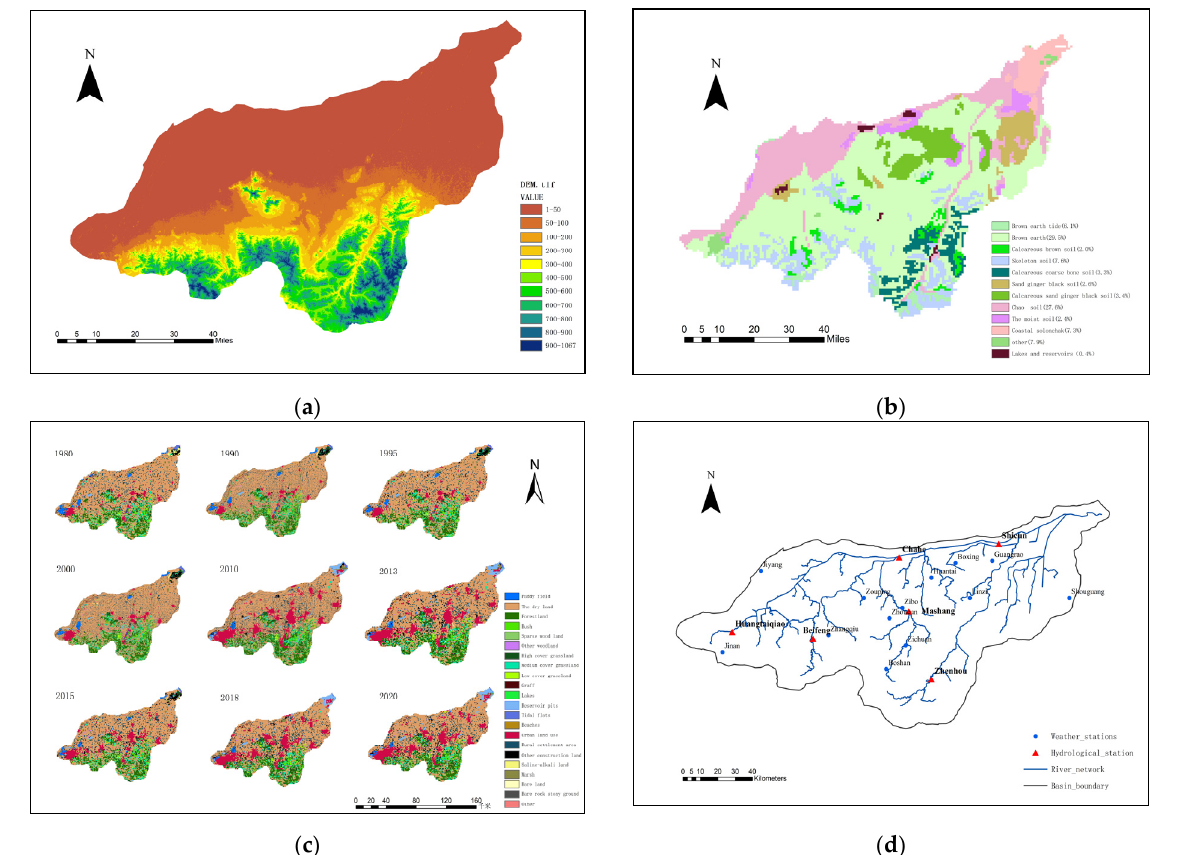
Figure 3. Basic hydrological data of Xiaoqing River basin: ( a ) Digital elevation map reflecting the topography of the study area; ( b ) soil type map, divided into 12 categories; ( c ) land use type map, divided into 22 categories; and ( d ) distribution of hydrological and meteorological stations, including 6 hydrological stations and 12 meteorological stations.